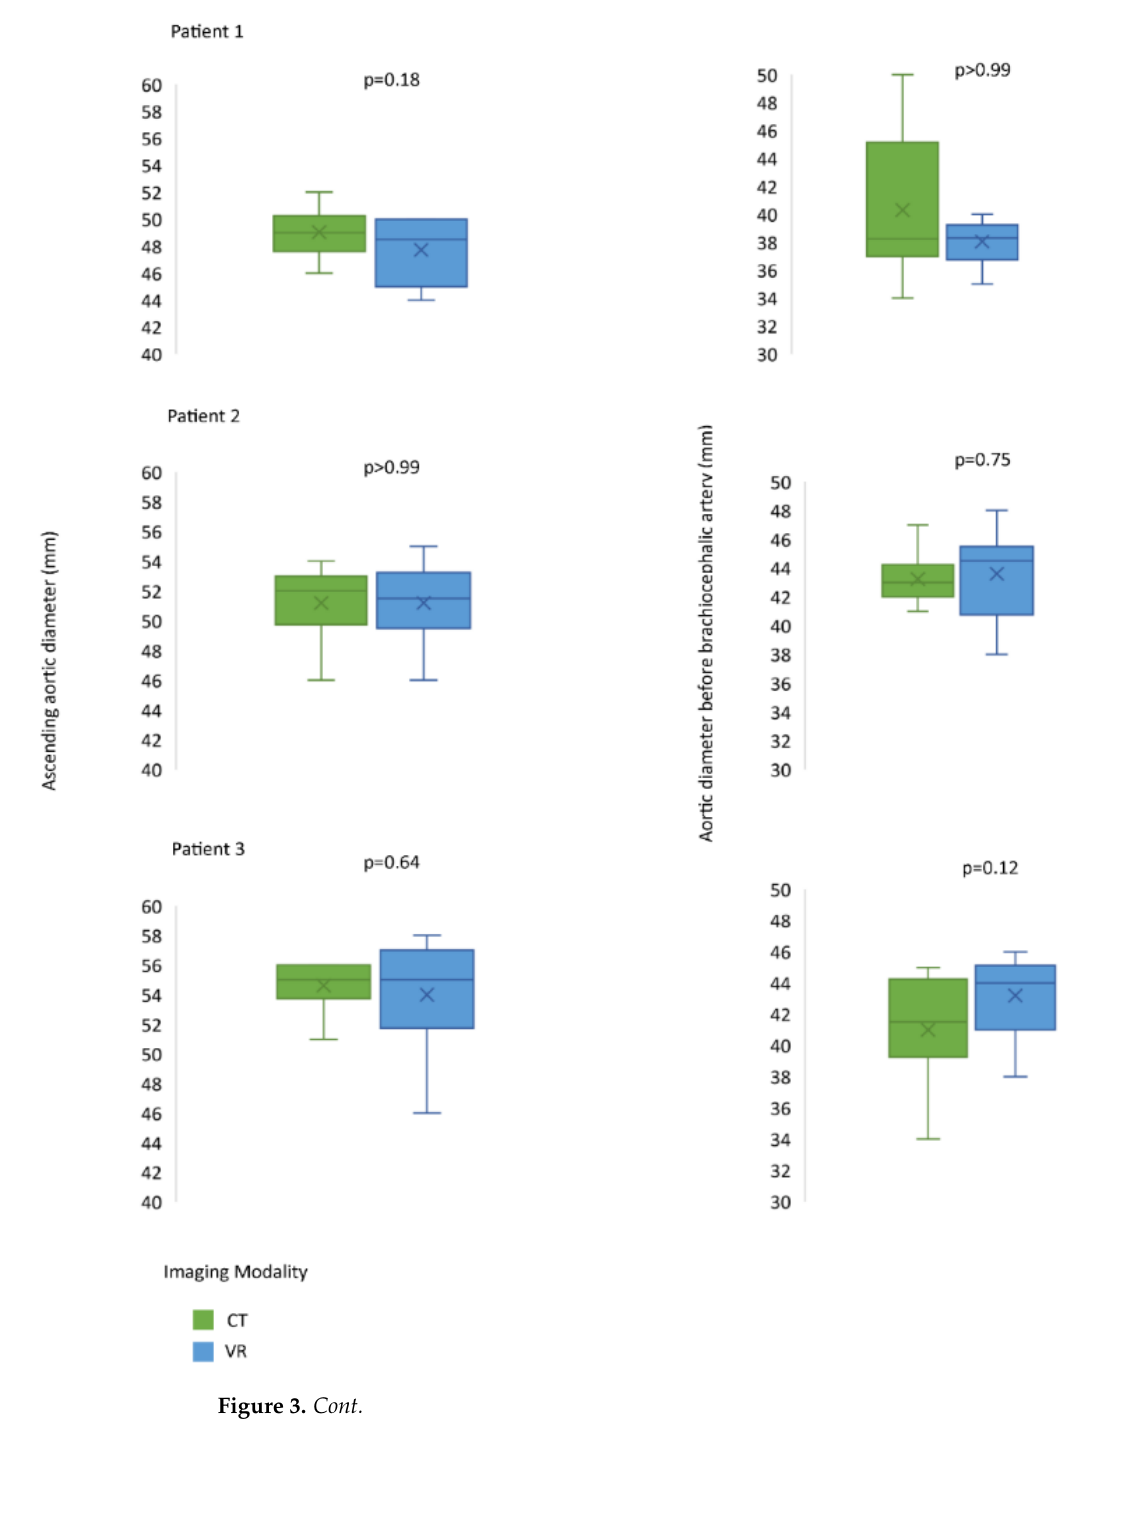
Figure 2. Questionnaire results of participating surgeons on the effectiveness of virtual reality soft- ware and hardware for the preoperative planning of ascending aortic